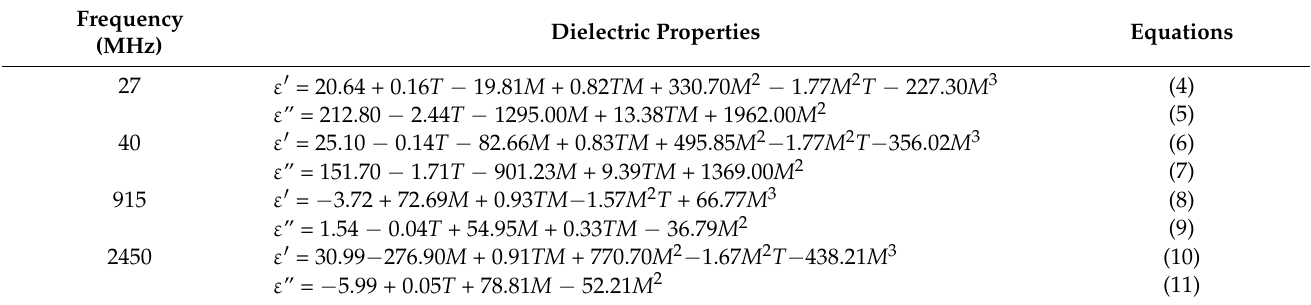
Table 2. Regression equations of the dielectric properties of wolfberries at four representative frequencies as a function of moisture content ( M , % w.b.) and temperature ( T , ◦ C).